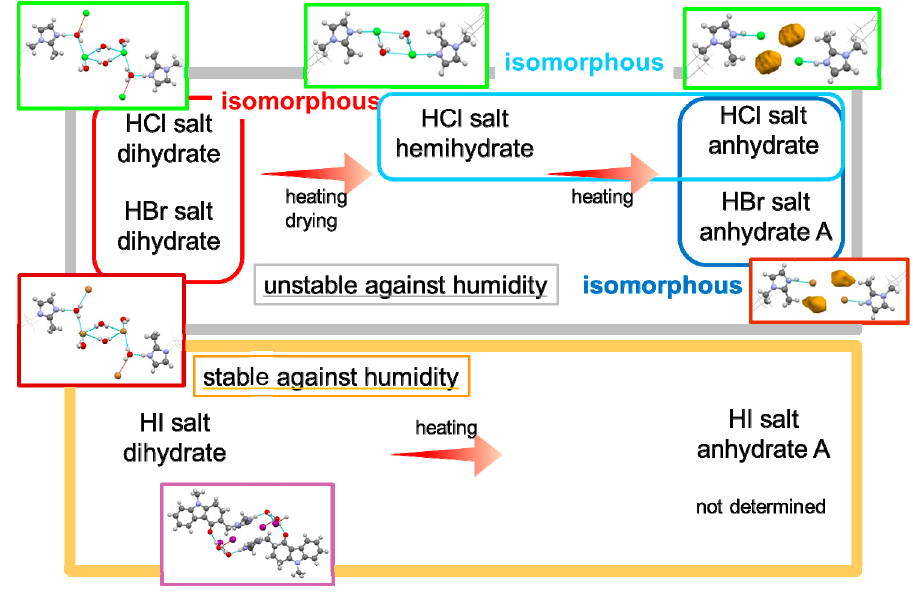
Figure 9. Schematic representation of the dehydration tendency of ondansetron salts.